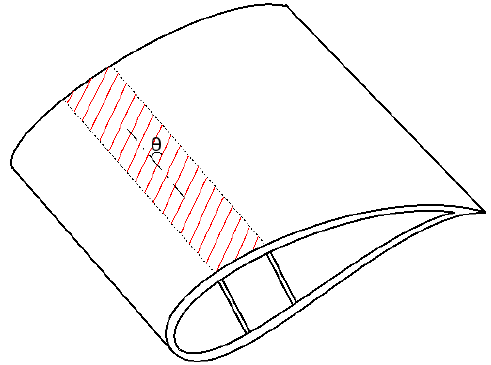
Figure 2. Definition of ply offset angle θ of fibre orientation (mirror lay-up) of uni-directional ma- terial on the spar caps of material BTC blades. on the spar caps of material BTC